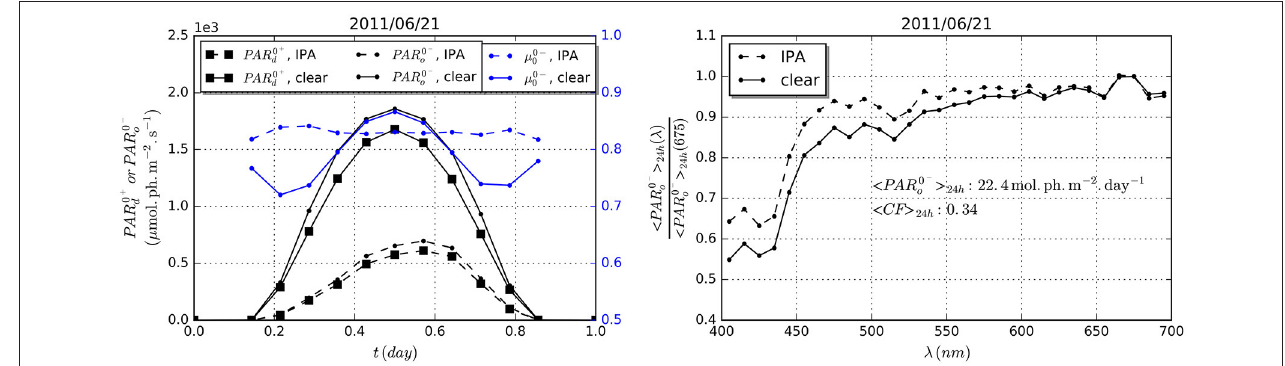
FIGURE 10 | (Left plot) Diurnal variation of the downward above-surface PAR (squares) and scalar below-surface PAR (dots) for the 21st of June and for a latitude of 55.5 ◦ N and a wind speed of 0 m/s. On the right vertical axis is reported the mean cosine below the surface. Two simulations are shown: (i) one for clear sky (solid lines) and (ii) one for “real” sky with cloud cover and cloud optical thickness as given by MERRA-2 and mixed with the clear-sky simulations using the Independent Pixel Approximation (IPA). (Right plot) Normalized spectral PAR at 675nm for both clear and IPA